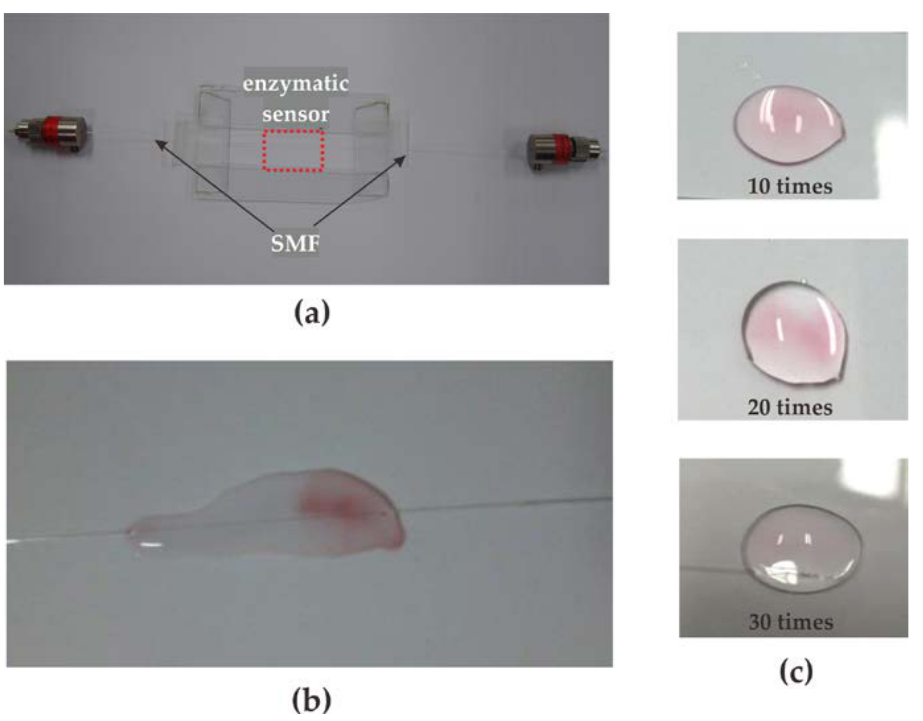
Figure 4. The pictures of the enzymatic no-core fiber sensor. ( a ) Photo of the sensor; ( b ) chromogen test result of GOx activity; ( c ) consecutive chromogen test for the reusability of sensor.